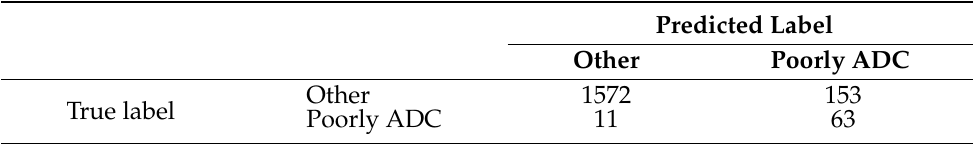
Table 3. Confusion matrix for the ensemble model with a threshold of